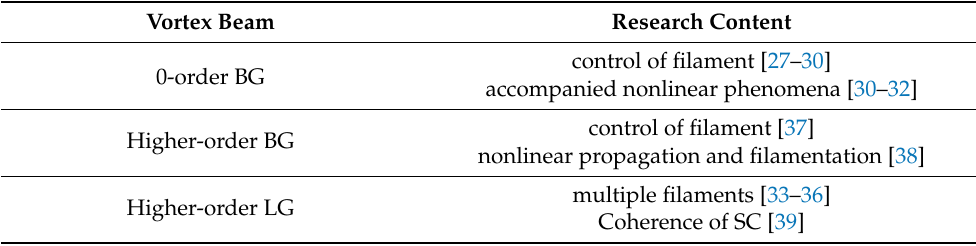
Table 1. Recent works in vortex